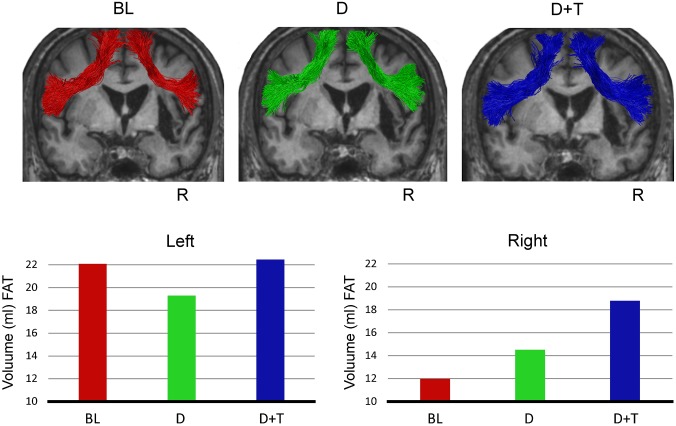
Tractography reconstruction of the left and right frontal aslant tracts (FAT) on the coronal plane in the three different time points. White matter microstructural changes are observed in the FAT in the baseline (BL), after drug treatment with donepezil (D) alone and after combined Donepezil and therapy (D + T). At the top, the FAT is showed bilaterally over imposed on the T1-weighted patient’s image in native space. At the bottom, the FAT volume is plotted for each hemisphere. Note that the volume pattern of the left FAT is more stable than the volume of the right FAT which increases progressively across the study phases. Neurological convention is used. R, right.